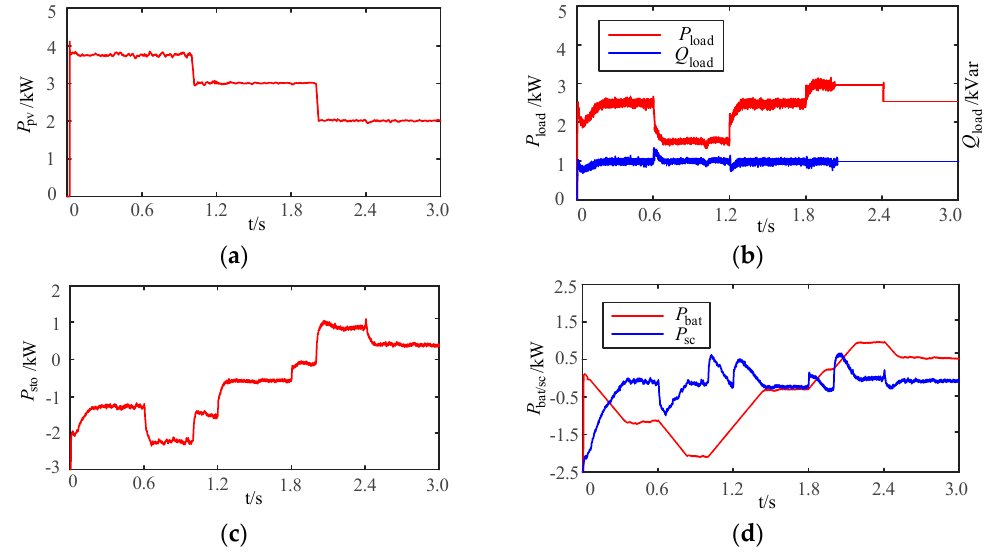
Figure 12. Simulation results of energy router in case 2: ( a ) PV generation; ( b ) Load consumptions; ( c ) Total charging or discharging power of the self-energy storage system; ( d ) Charging or discharging power of the battery and supercapacitor.